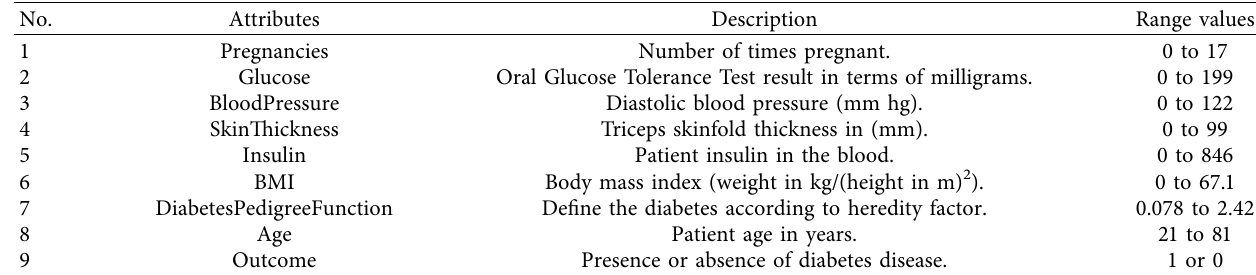
Figure 1: The proposed system flowchart. Table 1: Frankfurt Hospital, Germany, dataset